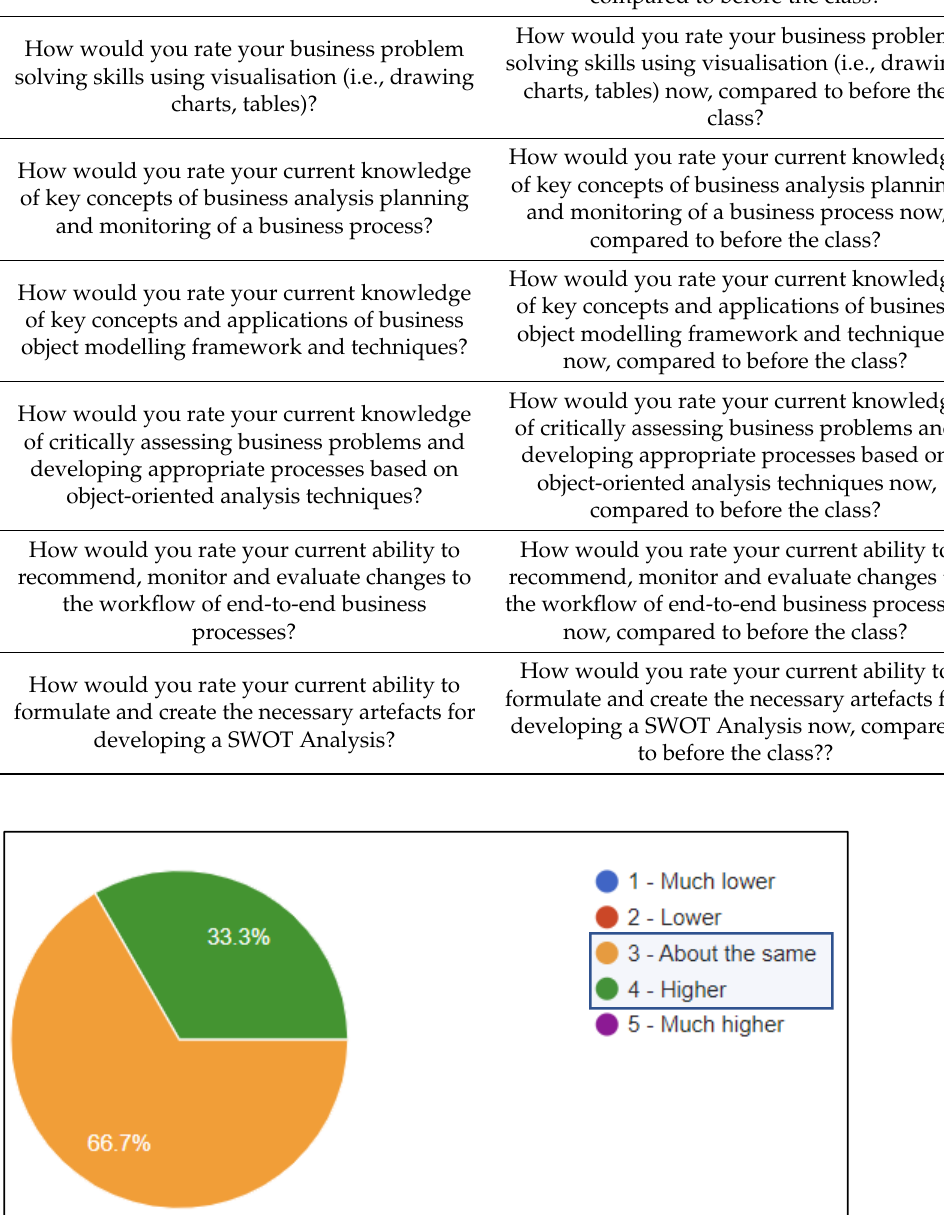
Figure 7. Students’ analysing skills after 1st smart classroom activity (Subject 1).